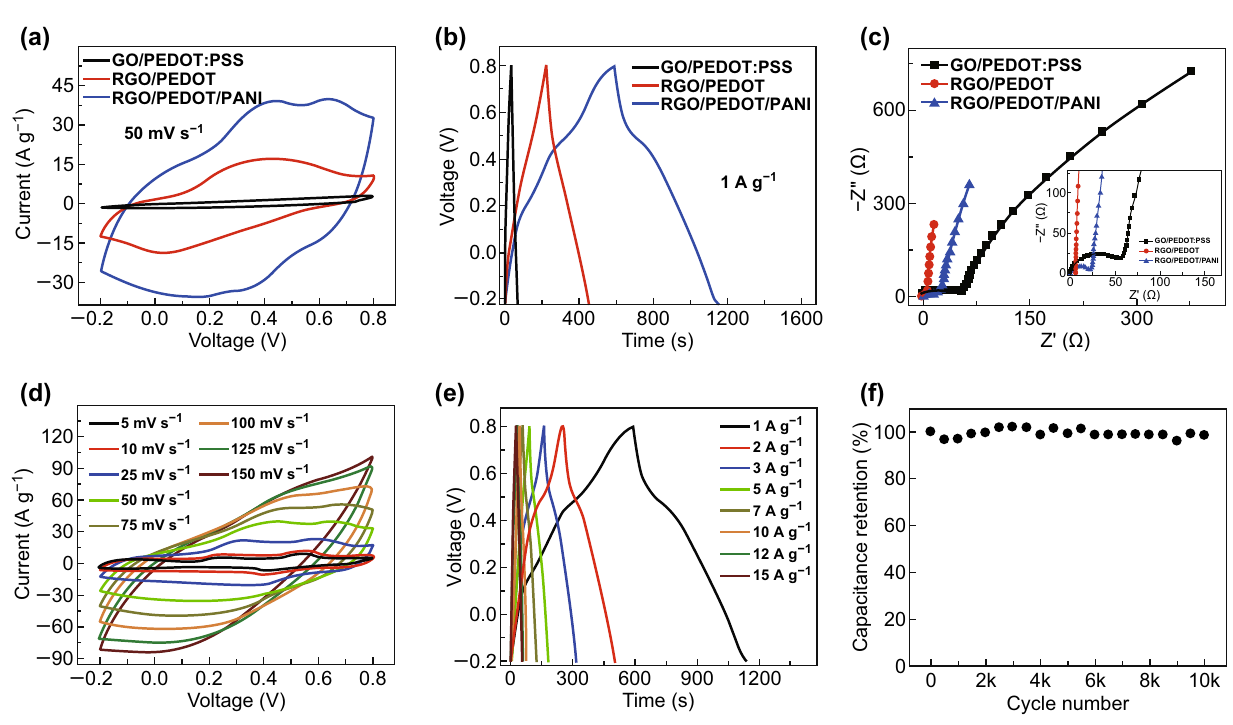
Fig. 3 a CV curves of GO/PEDOT:PSS, RGO/PEDOT, and RGO/PEDOT/PANI at 50 mV s −1 , b CD curves of GO/PEDOT:PSS, RGO/ PEDOT, and RGO/PEDOT/PANI at 1 A g −1 , c Nyquist plots of GO/PEDOT:PSS, RGO/PEDOT, and RGO/PEDOT/PANI, d CV curves of RGO/PEDOT/PANI at different scan rates, e CD curves of RGO/PEDOT/PANI at different current densities, and f cycle stabilities of RGO/ PEDOT/PANI hybrid at 5 A g